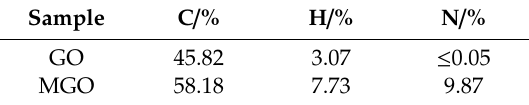
Table 1. Contents of C, H, and N in GO and MGO.